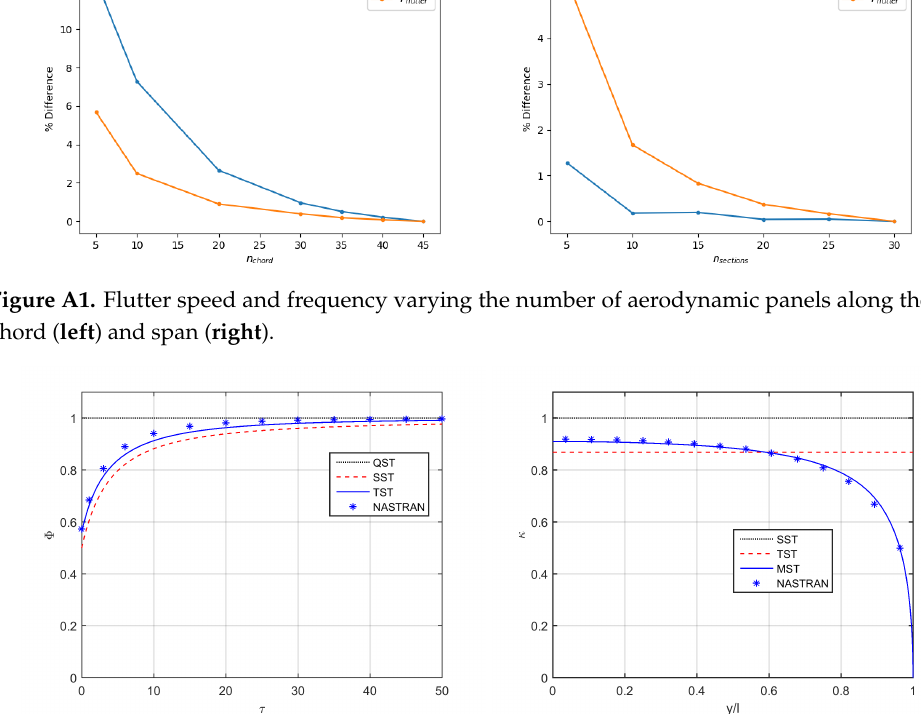
Figure A2. Indicial lift-evolution function from a step-change in the angle of attack ( left ), spanwise lift-decay function ( right ) for Loring’s wing in incompressible flow.